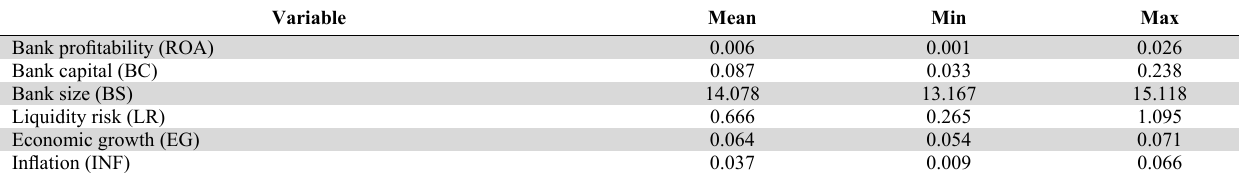
Descriptive statistics